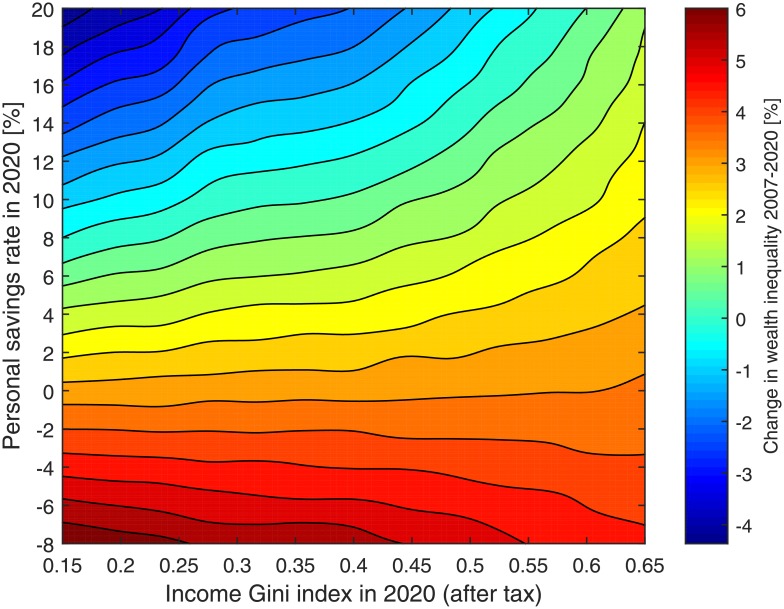
The joint effect of personal savings and income inequality on wealth inequality.This contour plot displays the change in wealth inequality between 2007 and 2020, according to the model results, given that the income inequality Gini index values were linearly changed up to a final value ranging between 0.15 to 0.65 (after tax) and the personal saving rates were linearly changed at the same time up to a final value between -8% to 20%. The other model parameters were extrapolated as done for the predicted results. The curliness of some of the contour is due to statistical error.